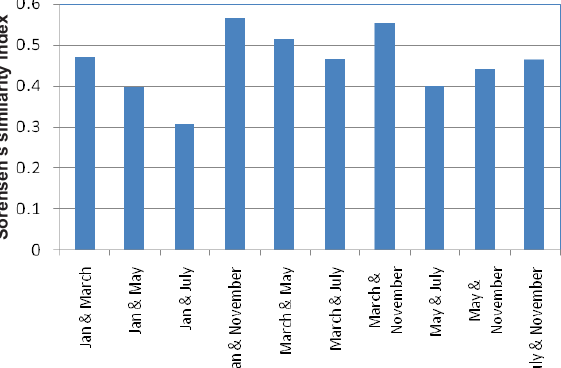
Figure 4. Butterfly species similarity between different seasons in sub-tropical lowland forests of Bhutan (January 2009–March